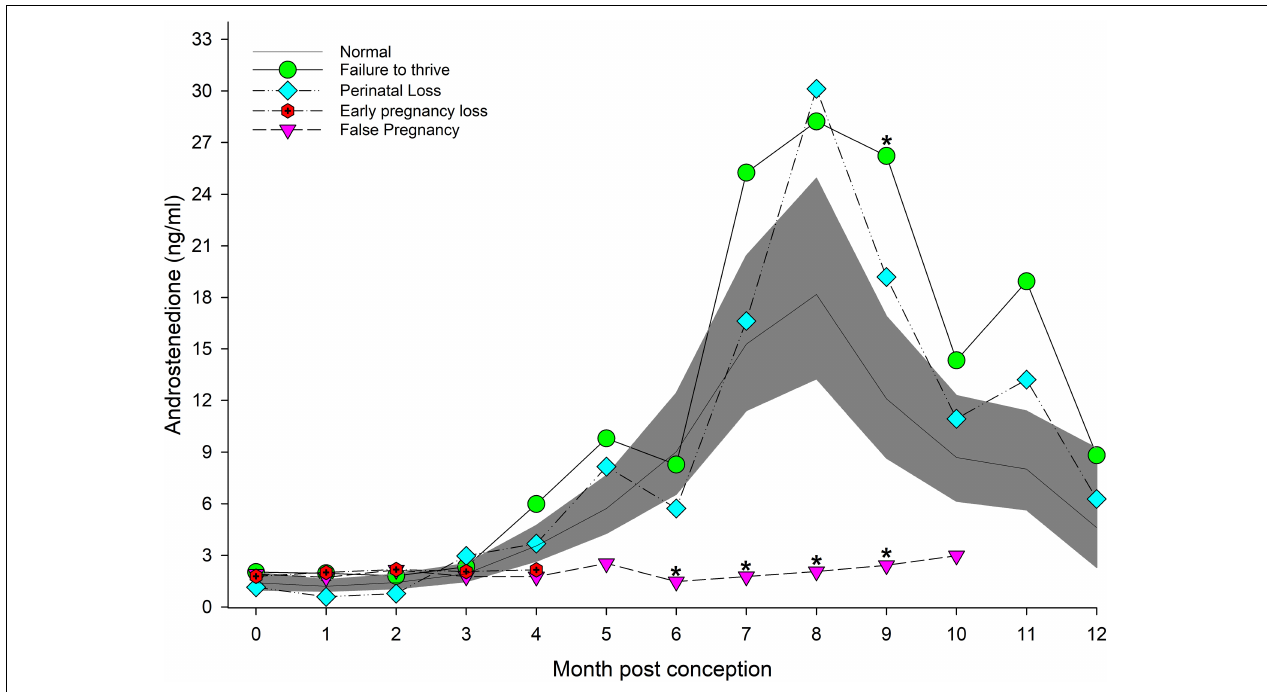
FIGURE 2 | The marginal predicted 95% CI for androstenedione during each month post-conception (MPC) of normal pregnancies as represented by the dark gray shaded portion of the graph and the mean by a solid black line. Line graphs with data points represent each abnormal pregnancy (marginal mean). MPC of abnormal pregnancies which have mean concentrations that are significantly different from normal are highlighted with an asterisk (*). Data were log transformed for analysis and then back-transformed for data presentation.